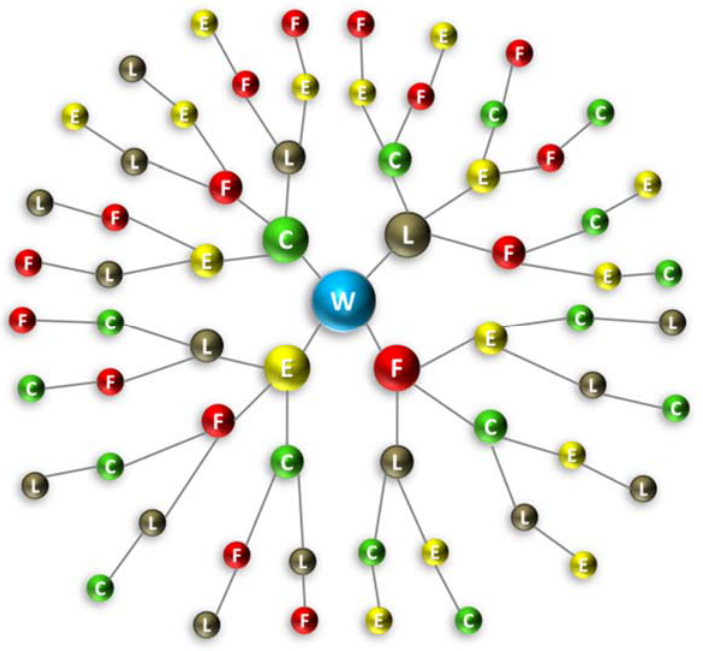
Figure 2. Nexus tree for Water showing the formation of all 24 unique fourth ‐ order interlinkages. Similar trees can be created for all five Nexus dimensions (W, E, F, L, C), creating a total of 120 unique fourth ‐ order interlinkages for the five ‐ dimensional Nexus.